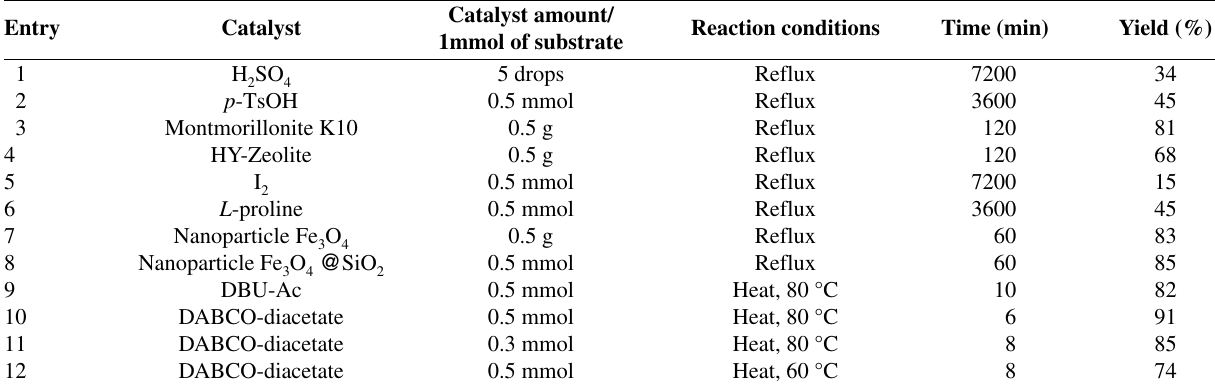
Table 1 . Effect of catalyst or media on the reaction of 4-chlorobenzaldehyde and β